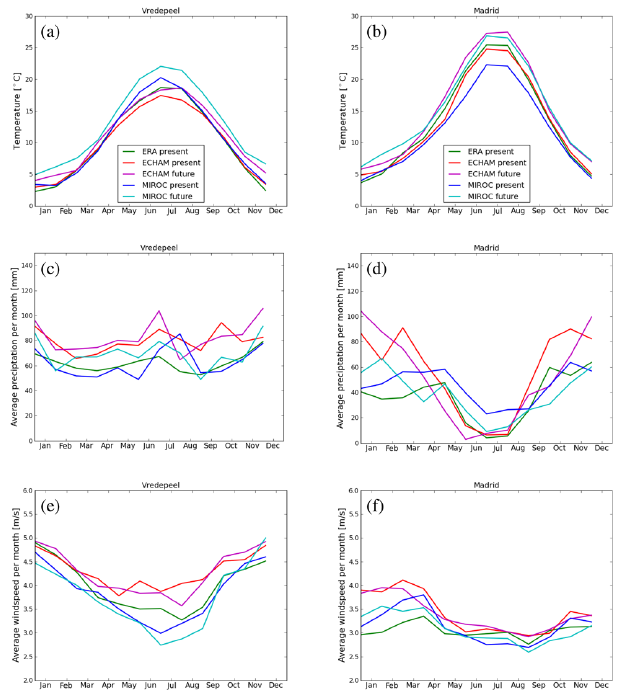
Fig. 4. Average annual cycles of monthly mean values for daily maximum temperature (a, b) , monthly mean precipitation (c, d) and monthly mean wind speed (e, f) at Vredepeel (left) and Madrid (right) derived from various downscaling experiments with